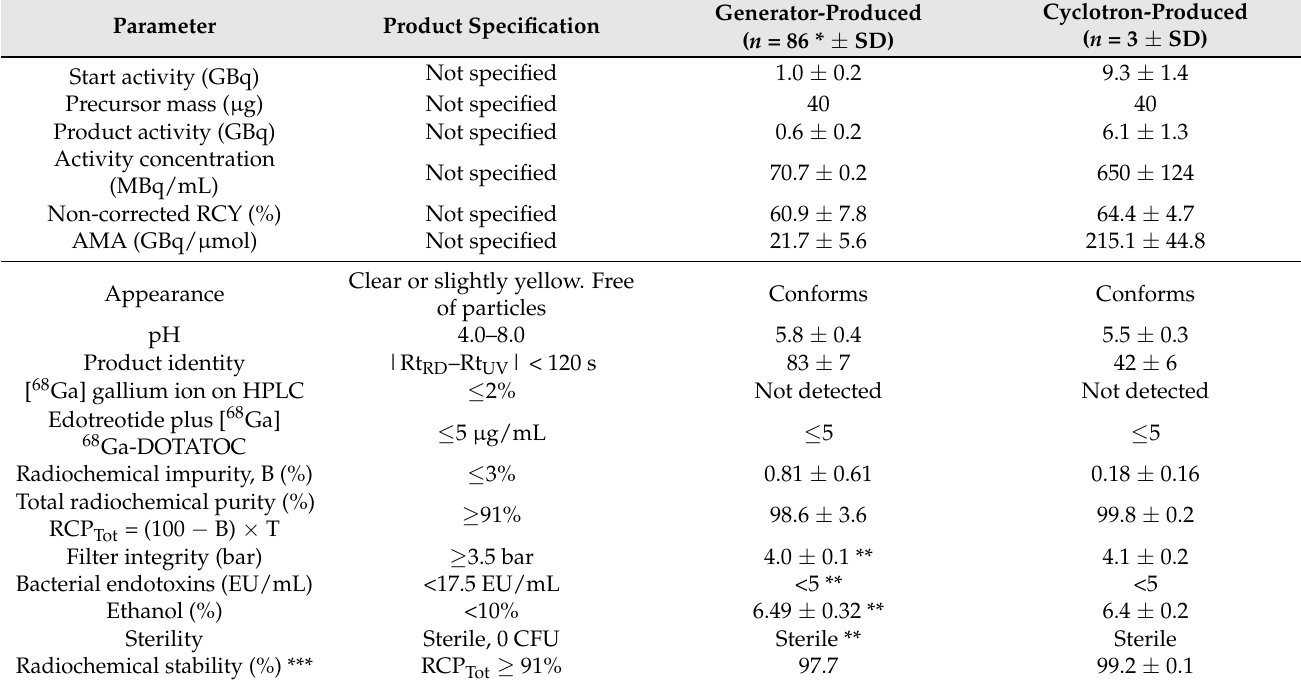
Table 3. Summary of syntheses and QC of [ 68